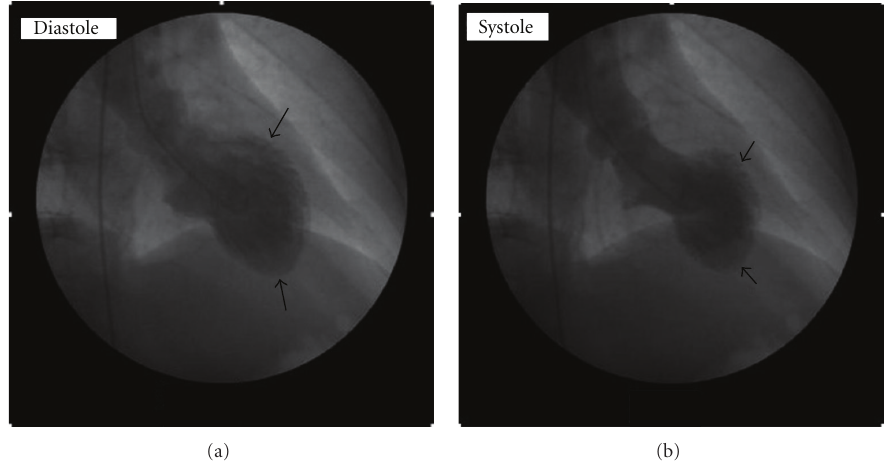
Figure 2: Diastolic and systolic frames from left ventriculography illustrating akinesis of mid and apical